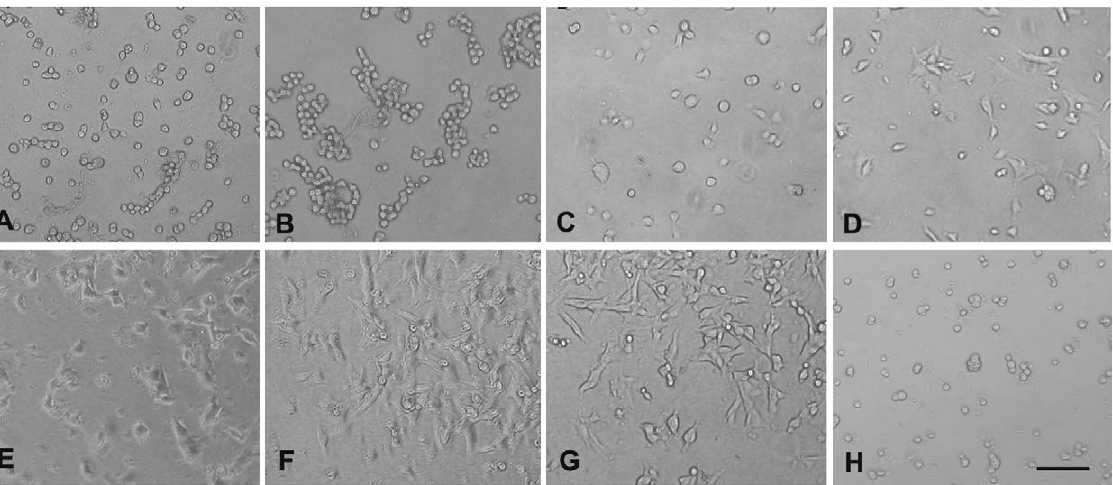
Figure 2. FSP supports mLEC attachment and spreading in a concentration-dependent manner. (A) BSA (10 ul/ml), (B) rhSPARC (10 ug/ ml), (C–G) FSP (5, 10, 20, 30, 40 ug/ml, respectively), and (H) FSP (10 ug/ml) were preincubated with anti-SPARC IgG (30 ug/ml) at 37 u C for 30 min prior to the coating. The proteins were coated onto wells overnight at 4 u C. mLECs were plated into each well in serum-free DMEM, and allowed to attach for 2 hr at 37 u C. Phase-contrast photomicrographs were taken on the 96-well plates under an inverted microscope equipped with a digital camera. Scale bar=50 um for all photographs.